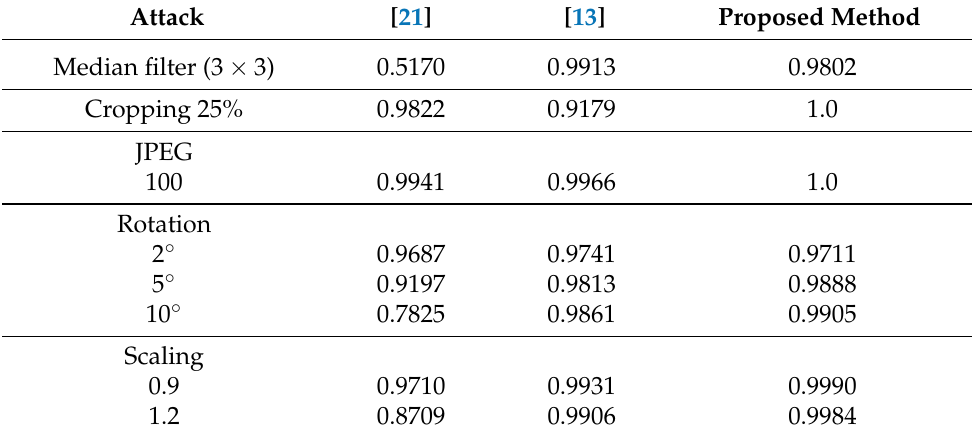
Table 17. Comparison of the robustness of the proposed algorithm with different methods against several attacks for Lena